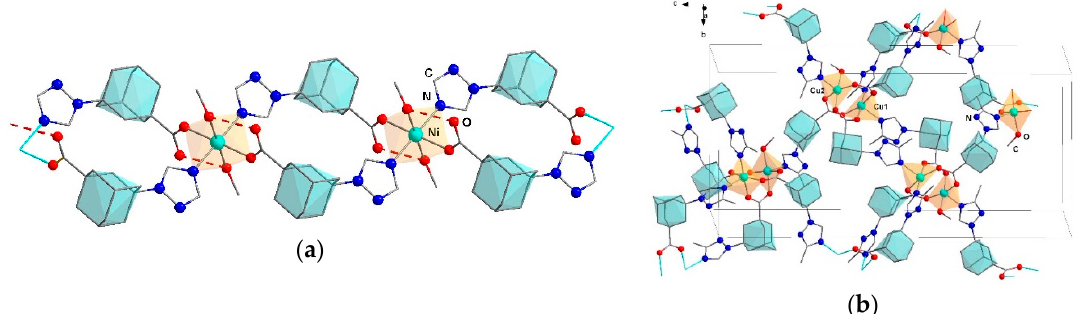
Figure 3. The structure of 1D chain of the complex 3 ( a ) and structure of the complex 4 ( b ). Adamantane units are coloured blue, coordination polyhedra of the central atoms are coloured orange. Hydrogen atoms and nitrates are omitted; dashed red lines indicate intramolecular hydrogen bonds.